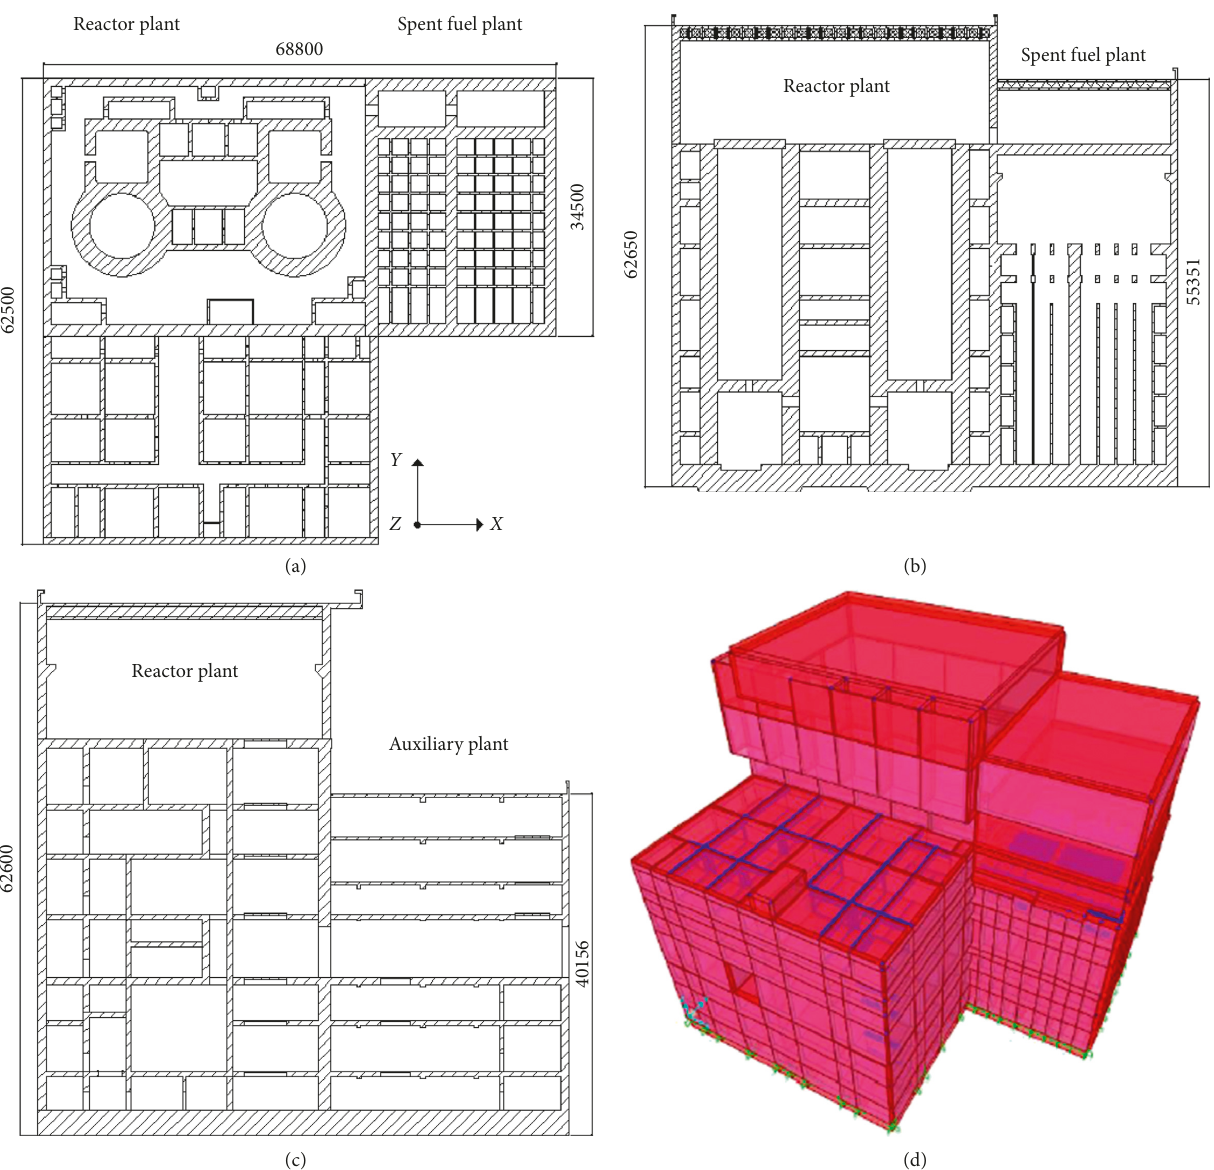
Figure 11: NPP layout. (a) Plan graph. (b) Reactor and spent fuel direction profile. (c) Reactor and auxiliary direction profile. (d) 3D